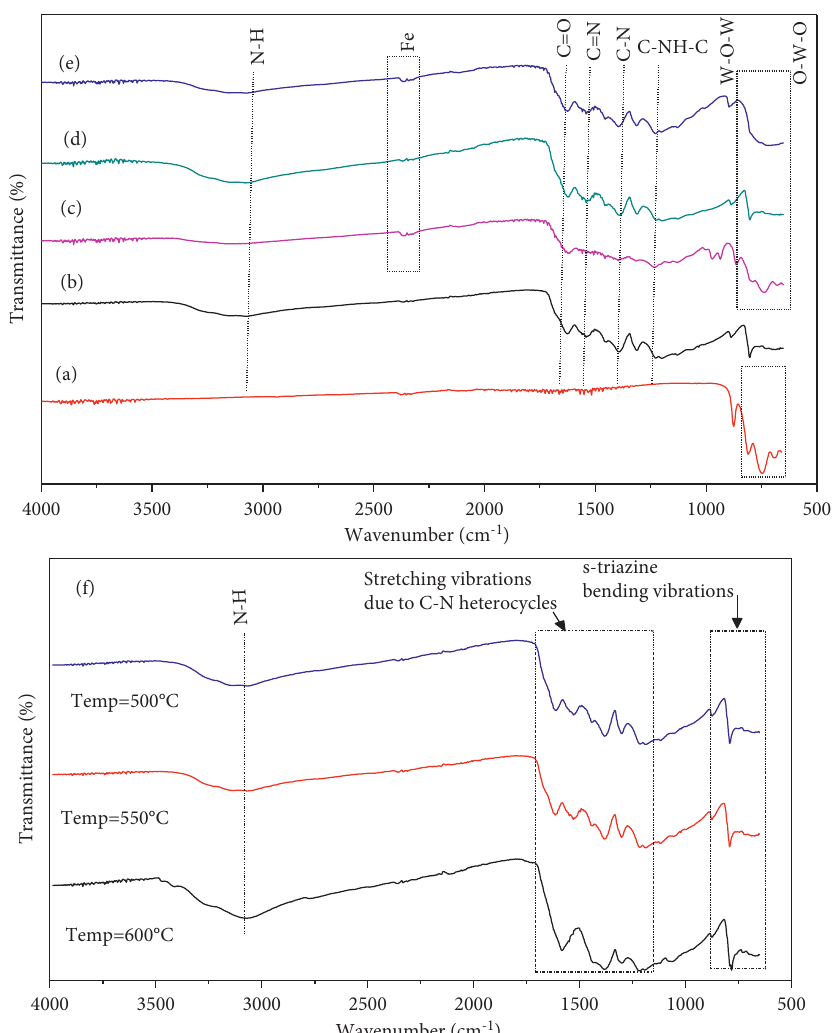
Figure 2: FTIR spectra of (a) AW, (b) g-C 3 N 4 , (c) Fe–CN, (d) CN-AW, (e) Fe-CN-AW, and (f) g-C 3 N 4 at various annealing